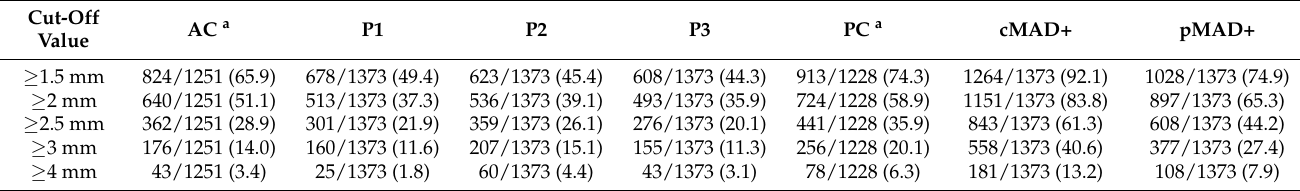
Table 1. Prevalence of MAD with different cut-off